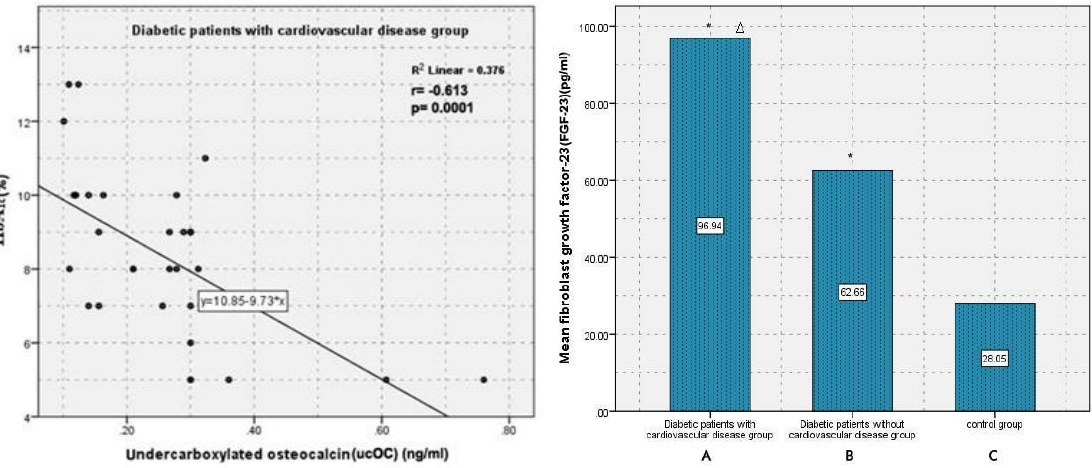
Figure 3. Correlation between undercar- boxylated osteocalcin (ucOC) (ng/ml) and HbA 1c in diabetic patients with cardio - vascular disease group